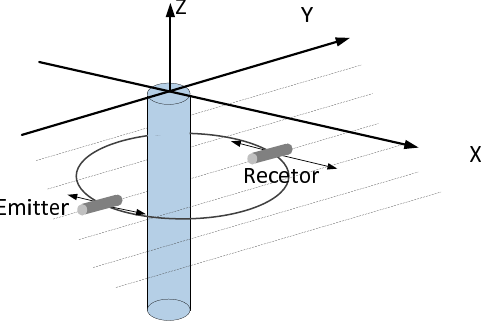
Figure 20. Arrangement of the transducers for the data capture for tomographic